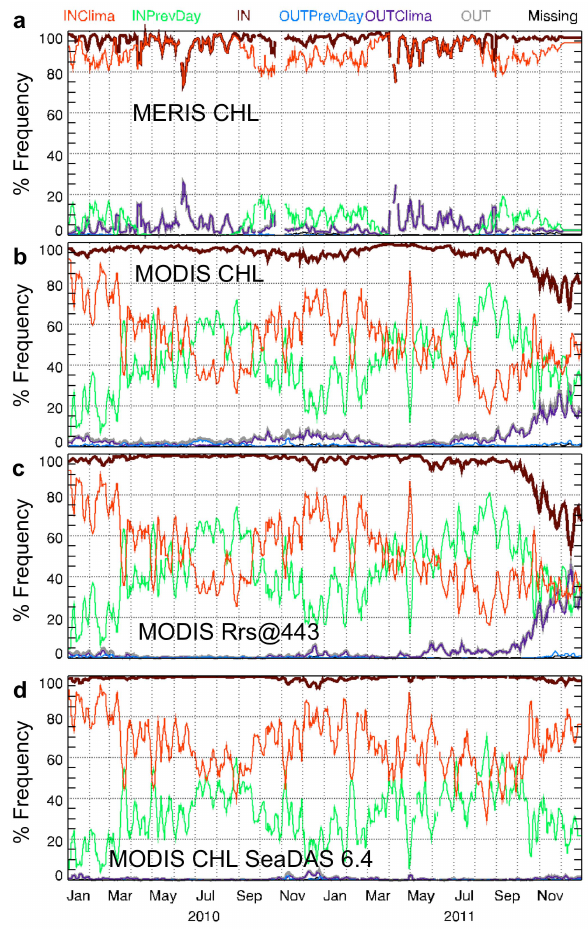
Fig. 7. Online validation statistics time series for the 2010–2011 time period, for (a) MERIS CHL, (b) MODIS CHL, (c) MODIS Rrs at 443nm processed using the current version of SeaDAS software (6.1), and (d) MODIS CHL processed using the latest available ver- sion of SeaDAS software (6.4). Colour legend refers to definition provided in Sect. 3.2 and graphically shown in Fig. 6. In addition, the total percentages of pixels falling in and outside relevant criteria are marked in dark red and grey, respectively. All lines represent the moving averages using a five-day